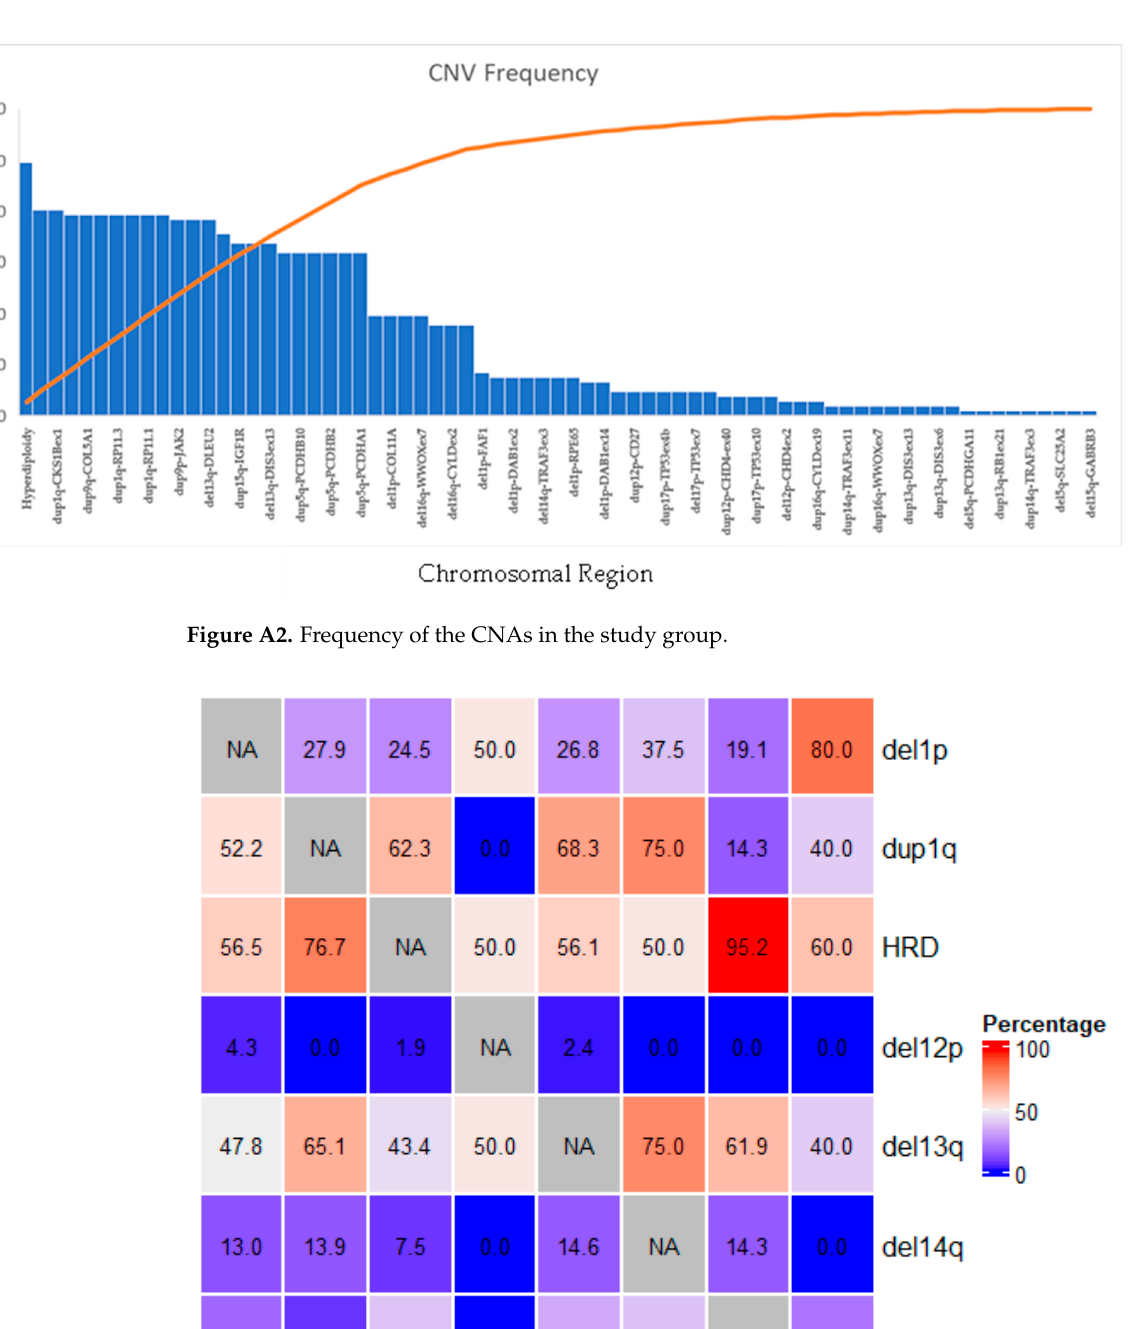
Figure A3. Heatmap of pairwise association between CNAs. The percentage was calculated from the positive group. Each row is a group.